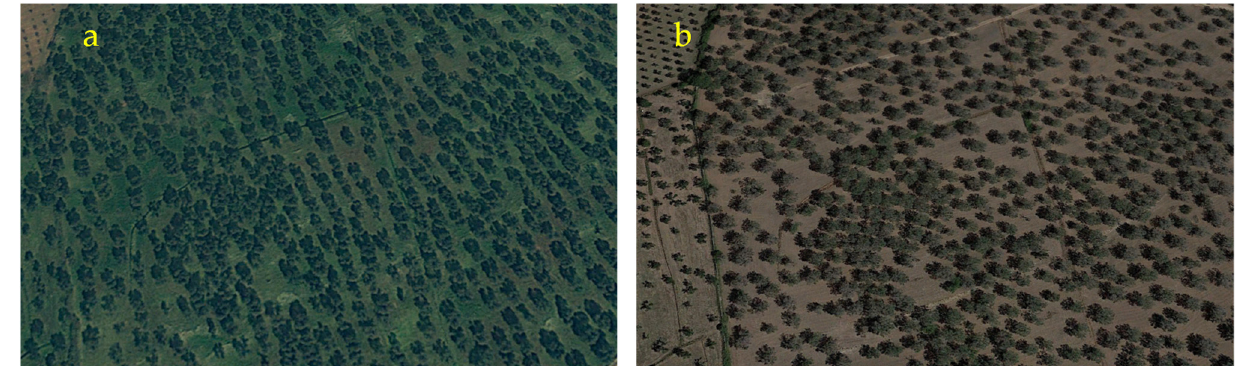
Figure 10. Representation of the same olive groves at a different time ( a ) the image refers to March, and it is possible to highlight the presence of grasslands like background vegetation; ( b ) the image refers to July, and it is possible to highlight the presences of bare soil like background.